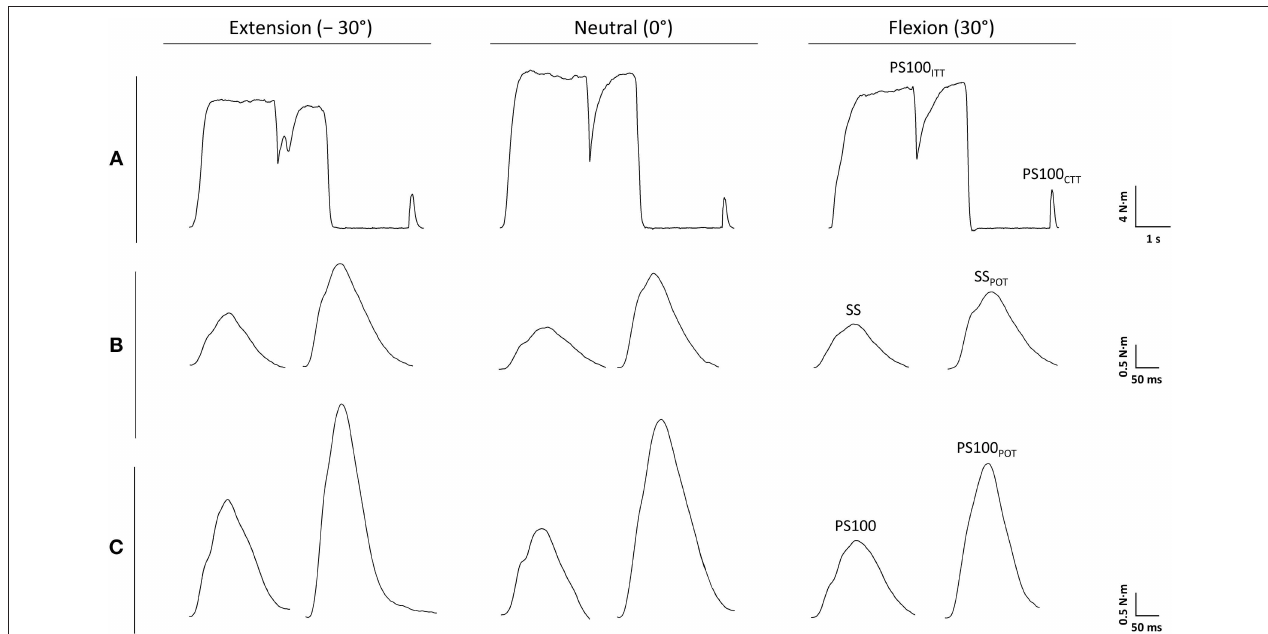
FIGURE 2 | Torque signals produced by voluntary (A) and electrically evoked contractions (B,C) of one representative participant. PS100, unpotentiated twitch torque evoked by paired electrical stimuli at 100Hz [inter-stimulus interval (ISI) 10ms]; PS100 CTT , control twitch torque evoked by paired electrical stimuli at 100Hz (ISI 10ms); PS100 ITT , interpolated twitch torque evoked by paired electrical stimuli at 100Hz (ISI 10ms); PS100 POT , potentiated twitch torque evoked by paired electrical stimuli at 100Hz (ISI 10ms); SS, unpotentiated twitch torque evoked by a single electrical stimulus; SS POT , potentiated twitch torque evoked by a single electrical stimulus. − 30 ◦ extension: long wrist flexor muscle length; 0 ◦ , neutral: intermediate wrist flexor muscle length; 30 ◦ , flexion: short wrist flexor muscle